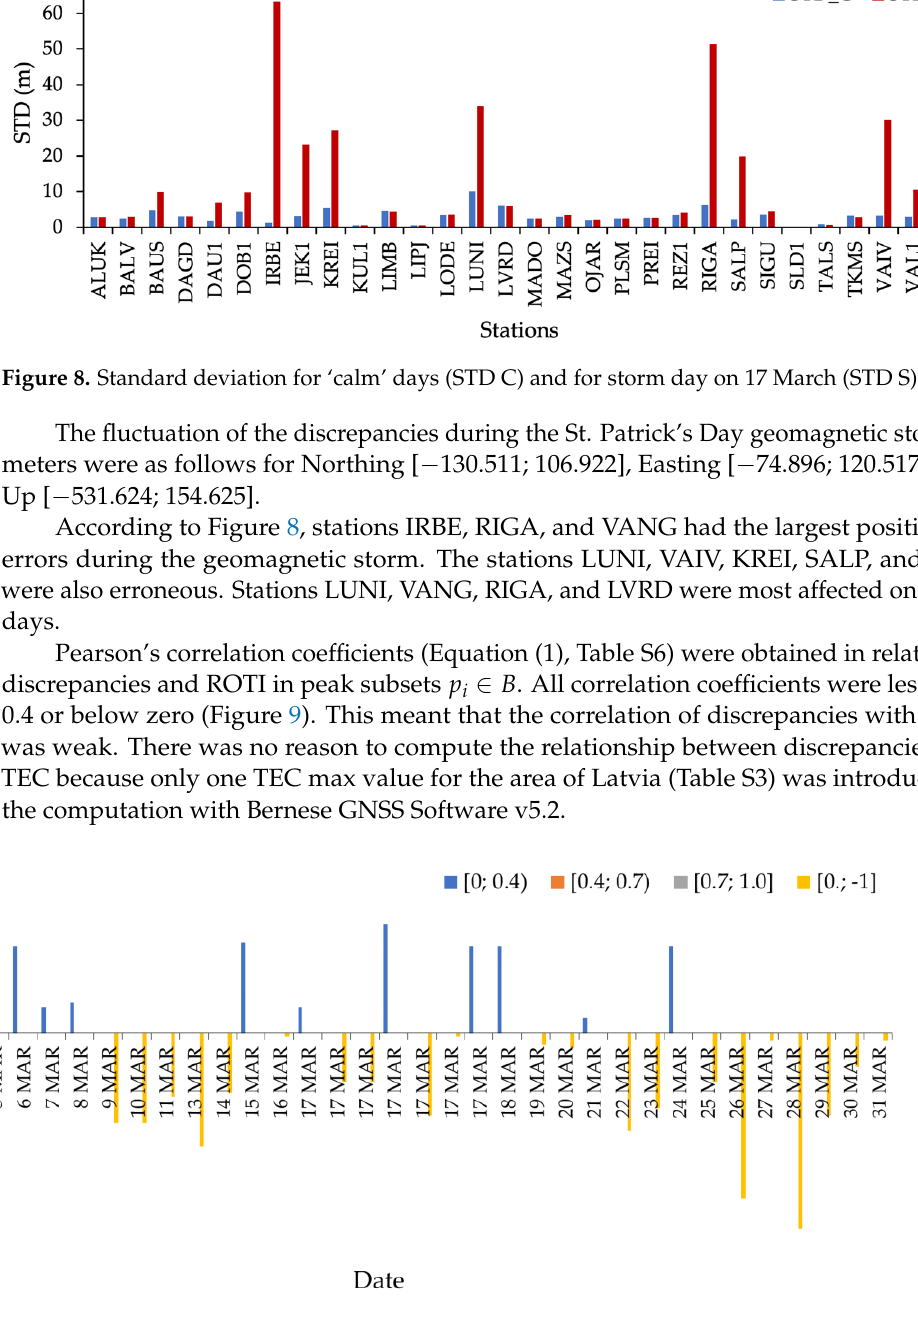
Figure 7. Mean discrepancies for ‘calm’ days (MEAN C) and for storm day , 17 March (MEAN S). The fluctuation of the discrepancies during the St. Patrick’s Day geomagnetic storm in meters were as follows for Northing [ −1 30.511; 106.922], Easting [ −7 4.896; 120.517], and Up [ −5 31.624; 154.625].